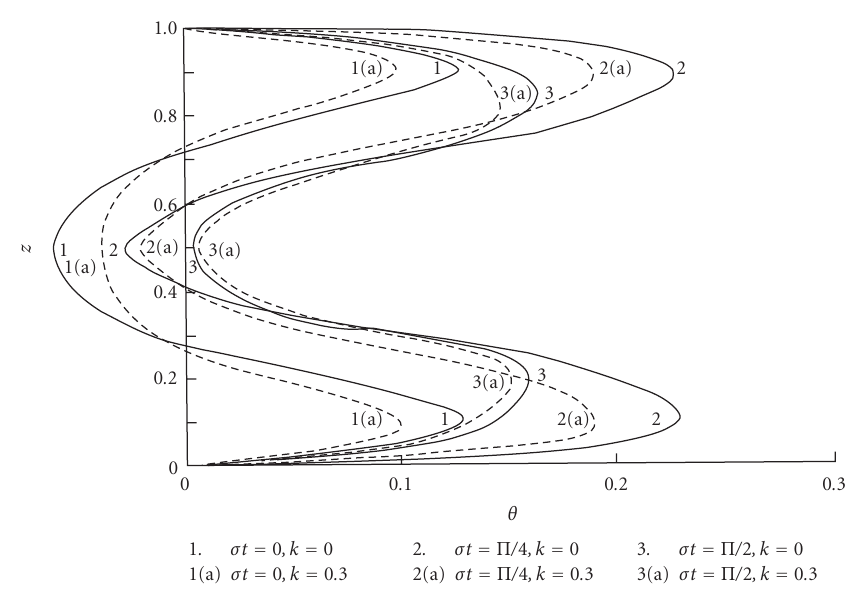
Figure 6.2. E ff ect of particle concentration ( k ) on the unsteady temperature profiles in a two-phase fluid when E c P r = 100. λ 1 = 0 . 1, λ 2 = 0 . 3.